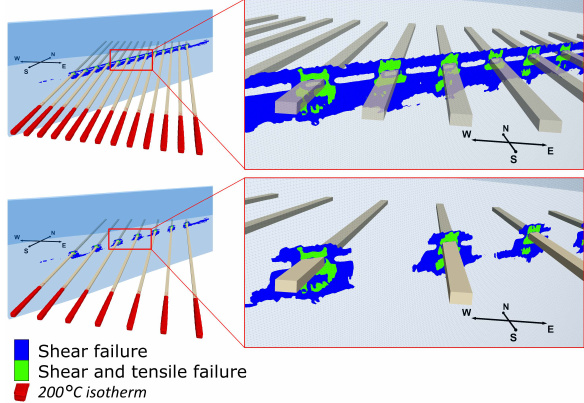
Figure 9. 3D distant ( left ) and close ( right ) views of shear and tensile failure at the fault plane for the non-isothermal scenarios with 60 m ( top ) and 140 m ( bottom ) pillar widths at a simulation time of 2000 days (end of UCG